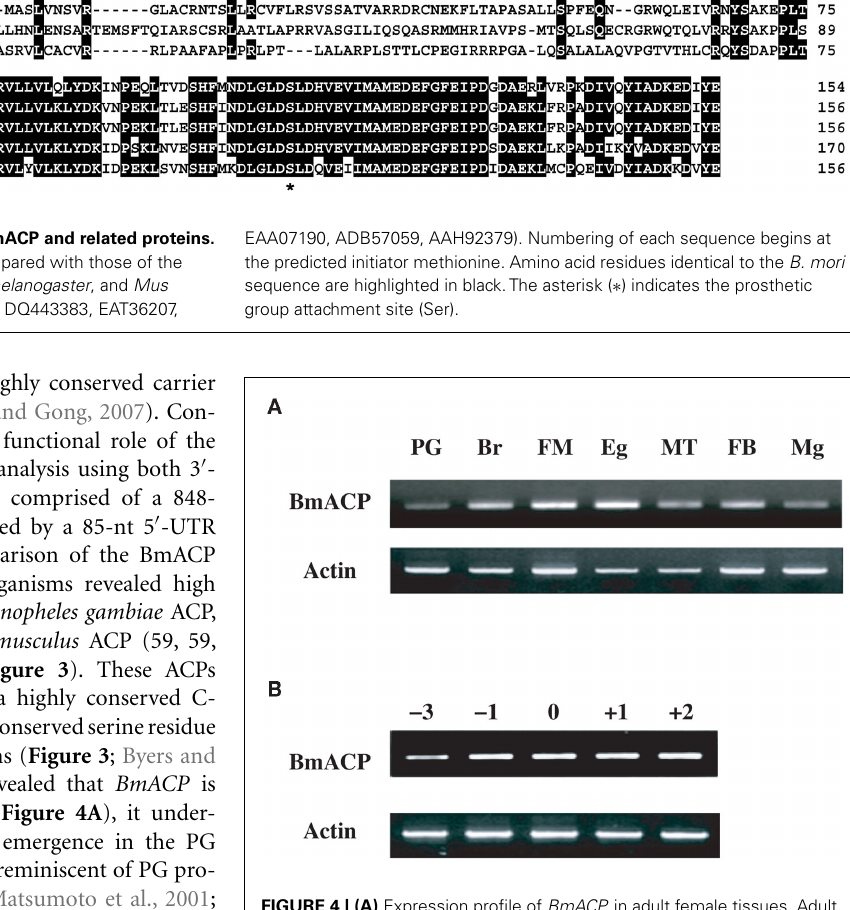
FIGURE 4 | (A) Expression profile of BmACP in adult female tissues. Adult tissues were dissected from newly emerged (day 0) p50 female moths: PG, pheromone gland; Br, brain; FM, flight muscle; Eg, unfertilized egg; MT, Malpighian tubule; FB, fat body; Mg, midgut. (B) Developmental expression profile of BmACP in the PG. PGs were dissected from p50 pupae at 3days ( − 3) and 1day ( − 1) before eclosion, and from p50 adults at 0day (0), 1day ( + 1), and 2days ( + 2) after eclosion. cDNAs were normalized to actin expression